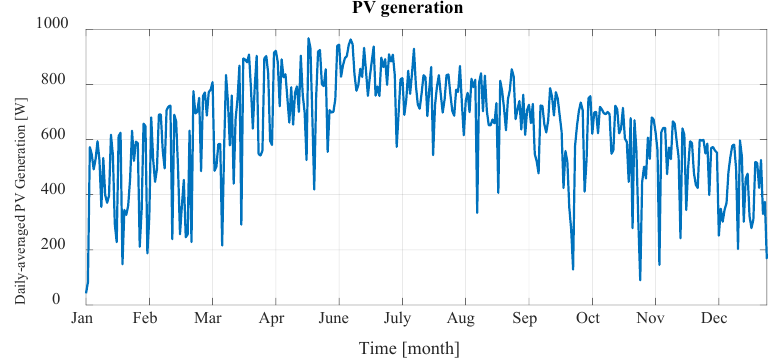
Figure A2. Efficiency curves of the converters.